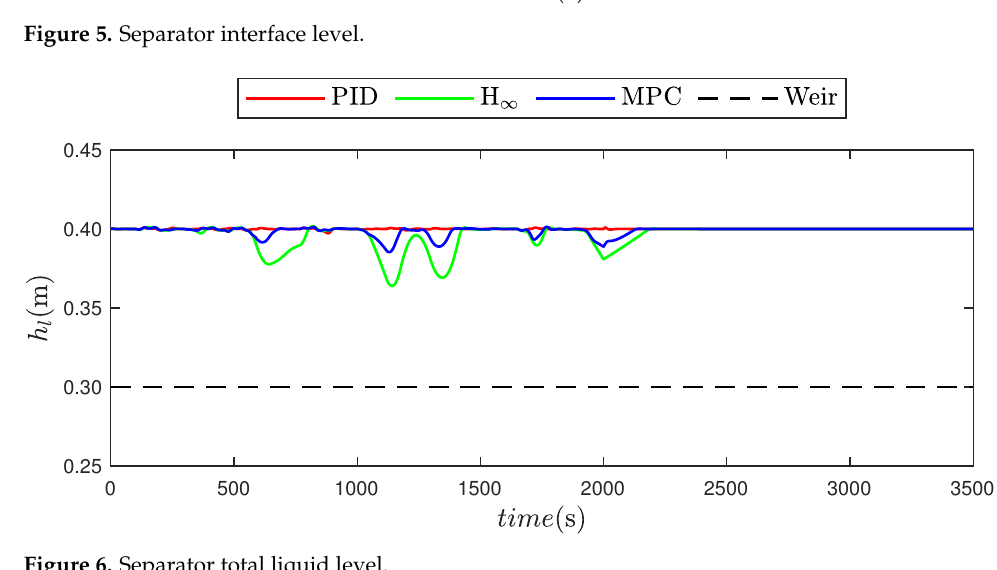
Figure 6. Separator total liquid level.